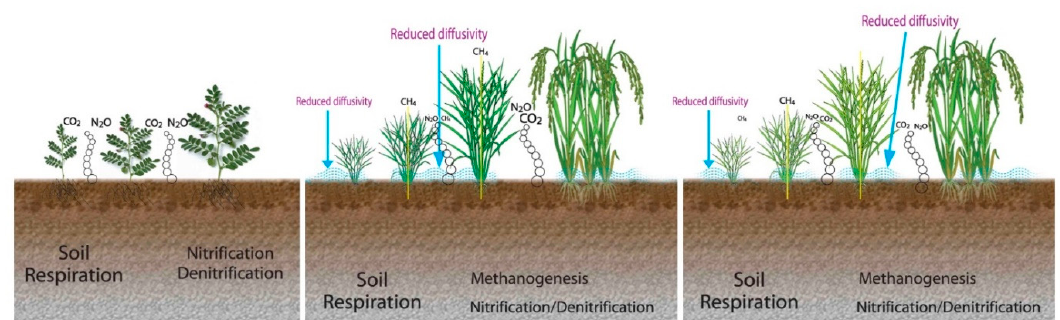
Figure 2. Conceptual diagram of soil processes responsible for greenhouse gas synthesis and emissions under the contrasting wetting and drying conditions in rice-based cropping systems [Adapted from Alam [53]. Soil heterotrophic respiration and nitrification processes mainly take place in aerobic condition to facilitate the emission of CO 2 and N 2 O, while methanogenesis and denitrification are dominant under anaerobic condition, discharging CH 4 mainly and insignificant amount of N 2 O to the atmosphere. In Texas rice fields, average CH 4 emission was 106 mg m − 2 d − 1 for continuous irrigation, 56 mg m − 2 d − 1 when the field was drained in the middle of the cropping cycle, 13 mg m − 2 d − 1 when the field was drained three times and 151 mg m − 2 d − 1 for a late continuous irrigation [210]. Water management between crops is also an important factor. A dry fallow emitted less CH 4 during the next crop cycle than a wet fallow [227]. Increasing water percolation in soil might also reduce CH 4 emission [228].